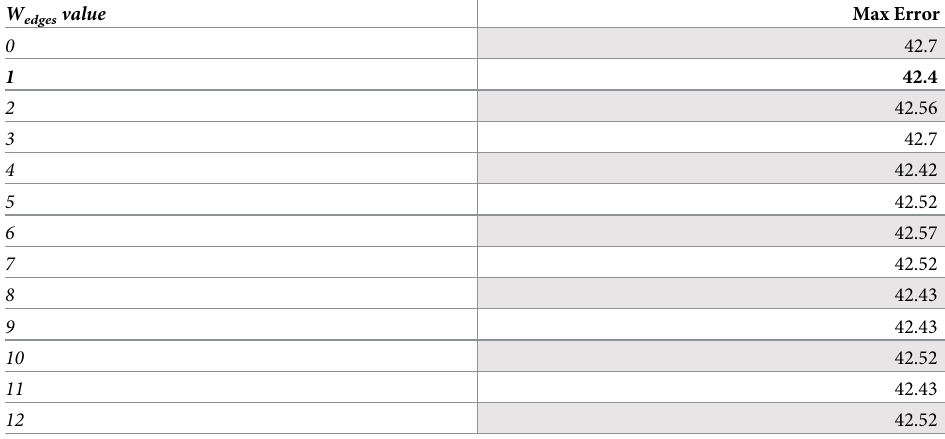
Table 3. Results of the preliminary experiment for W edges parameter.